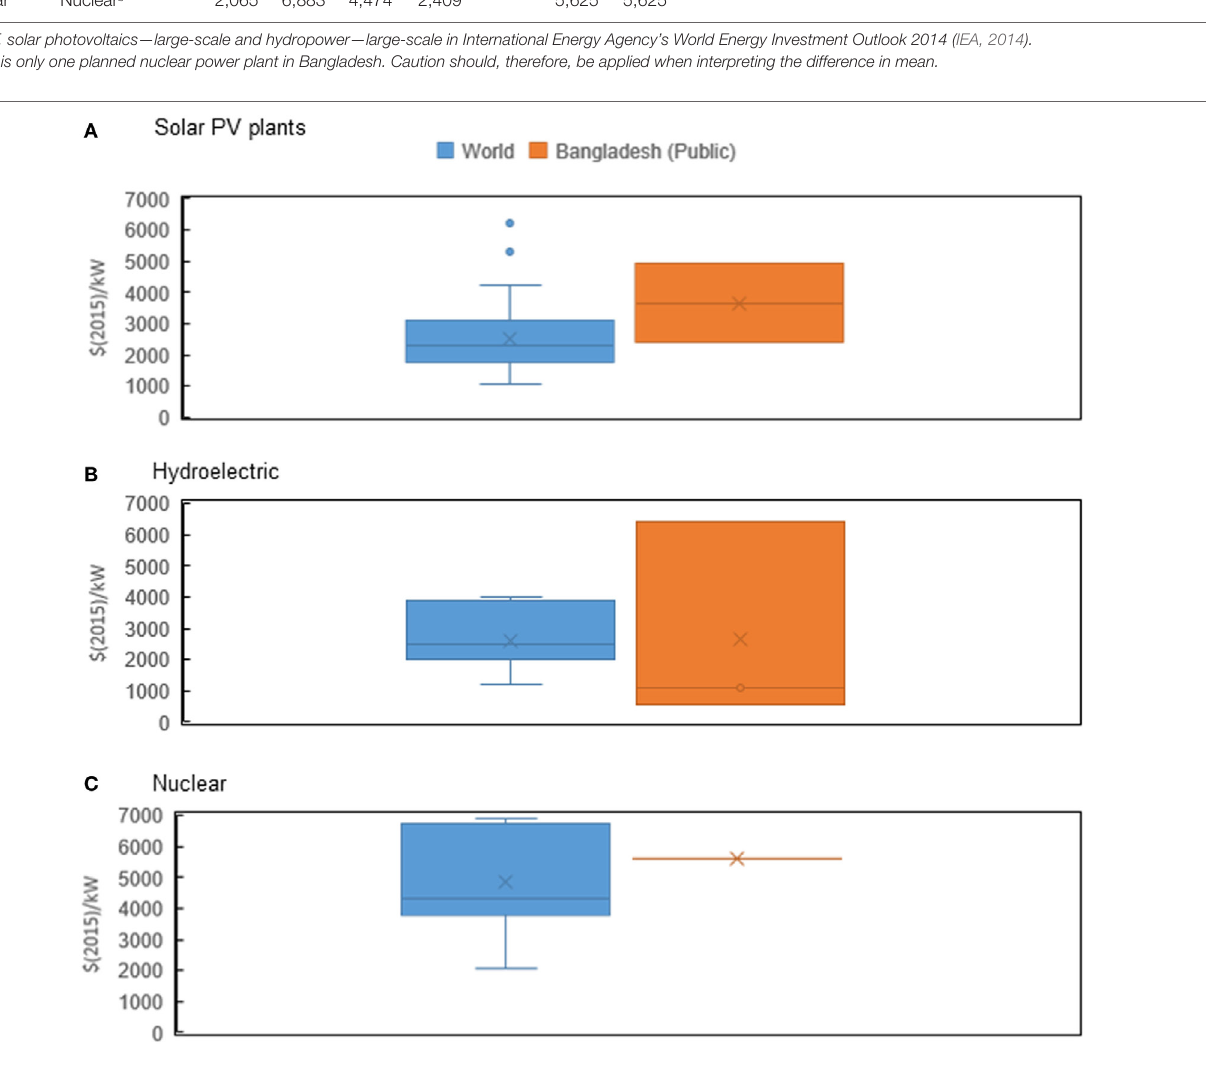
FigUre 4 | Capital cost comparison among nuclear and renewable power plants from different country regions with Bangladesh. In the case of solar PV plants, mean capital cost of Bangladesh is lower than the world mean. However, the installed capacity is only 12 MW. Mean capital cost for hydroelectric plants is also lower than that of global mean capital cost. The reason behind this lower cost is the later units were in the same plant side, which reduced the ancillary cost. For nuclear, only one plant is going to be built in Bangladesh by 2030, and its cost would be significantly higher than that of the world mean capital cost. (a) Solar PV plants. (B) Hydroelectric. (C) Nuclear.